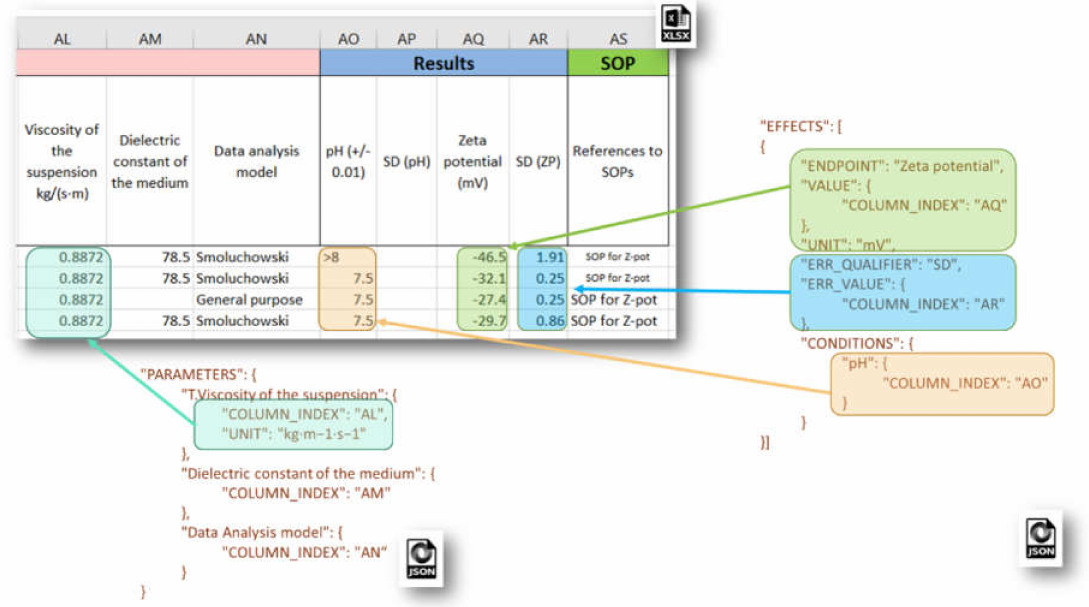
Figure 8. JSON configuration for Protocol Application parameters ( left ) and E ff ect Record (measurement) value, error value, and experimental conditions ( right